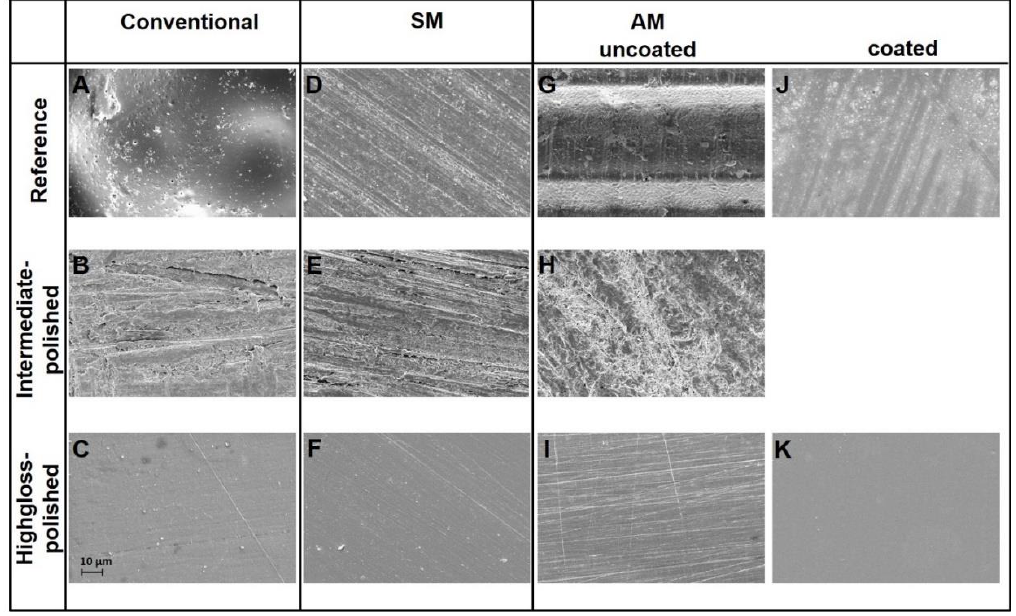
Figure 6. REM images in conventional group ( A ): reference; ( B ): intermediate-polished; ( C ): highgloss-polished), SM group ( D ): reference; ( E ): intermediate-polished; ( F ): highgloss-polished), and AM group ( G ): reference; ( H ): intermediate-polished; ( I ): highgloss-polished; ( J ): coated; ( K ): coated + polished).